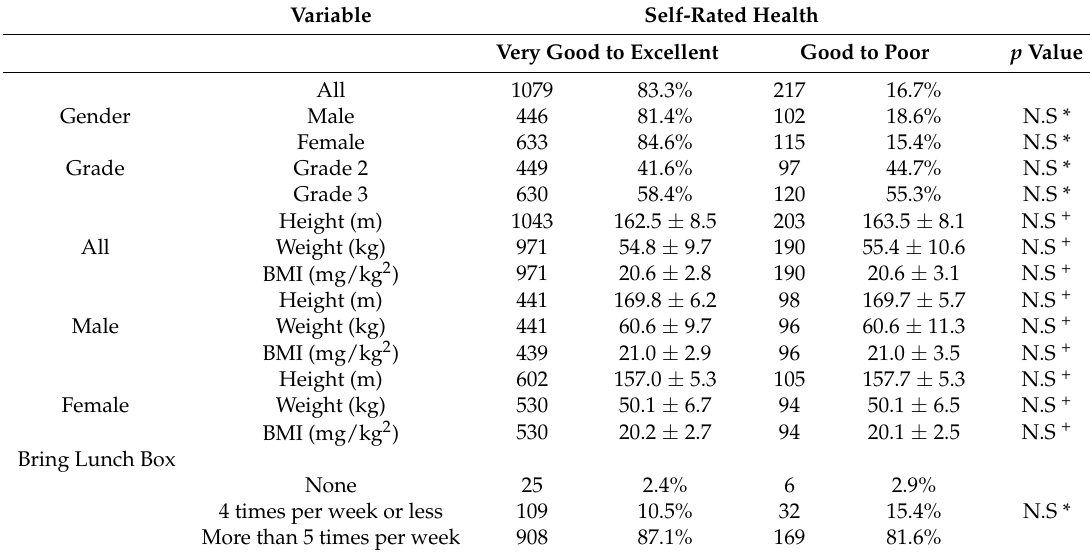
Table 1. Participant baseline characteristics classified by self-rated health ( n =